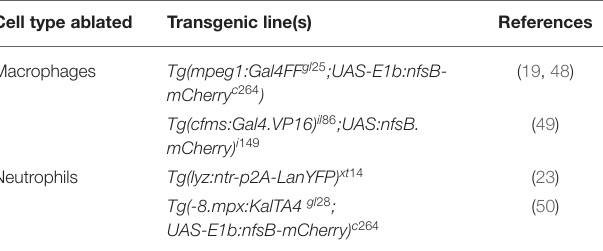
TABLE 3 | Examples of transgenic lines routinely used to manipulate phagocyte